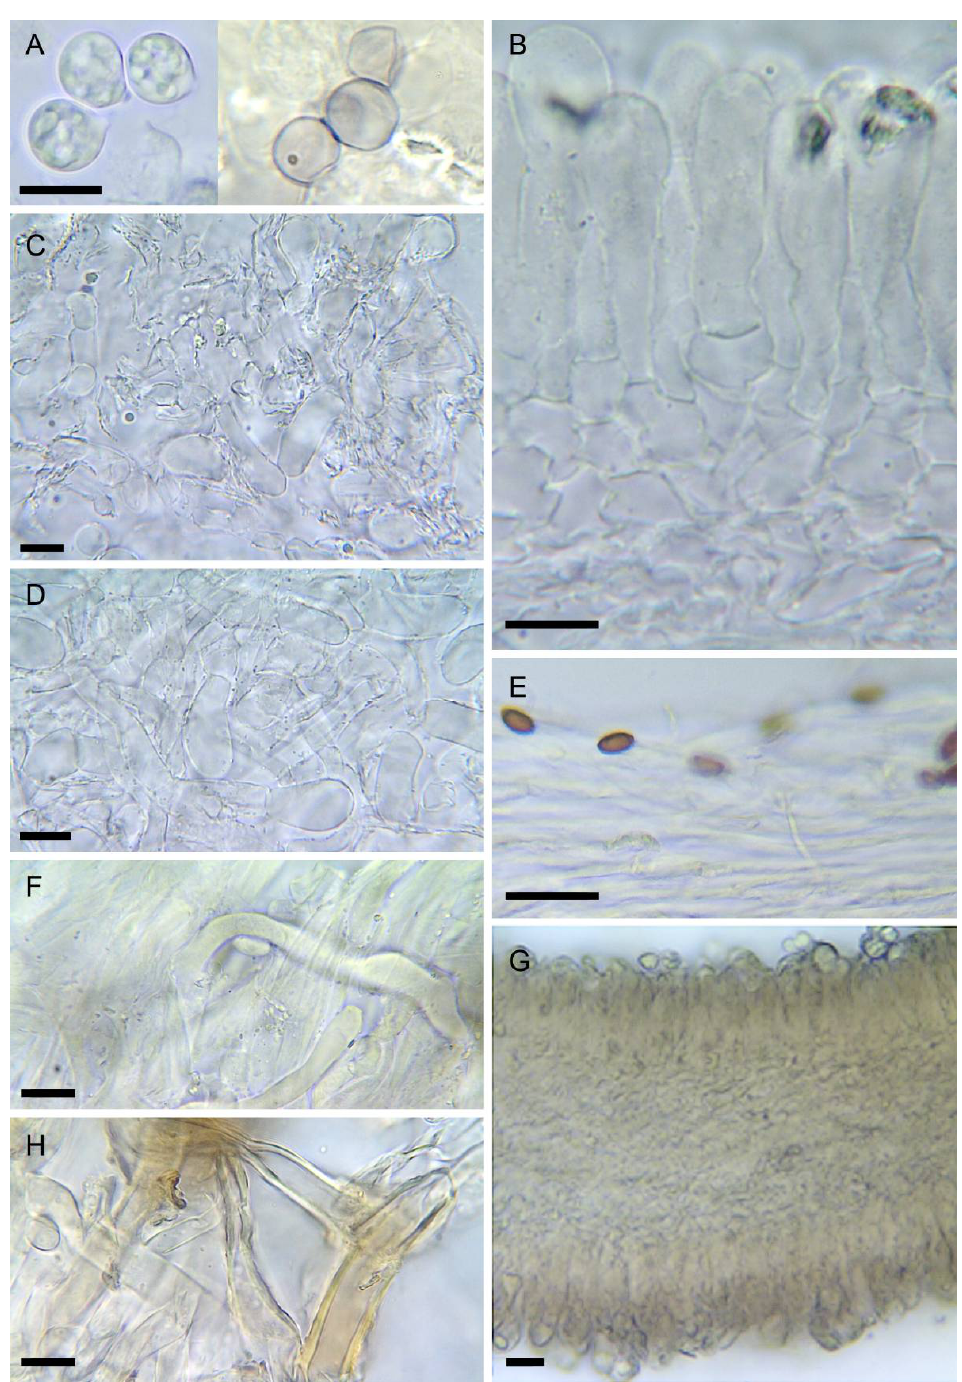
Figure 8. Amanita virosa (LIP:0402243). ( A ) Basidiospores. ( B ) Hymenium and subhymenium. ( C ) Elements of lamella edge. ( D ) Elements of partial veil (upper surface). ( E ) Pileipellis, radial section. ( F ) Hyphae in subpellis showing two thromboplerous hyphae. ( G ) Hymenophore, longitudinal section. ( H ) Universal veil, outer surface. All observations in 5% KOH solution except A (left): Melzer. Bar = 10 µ